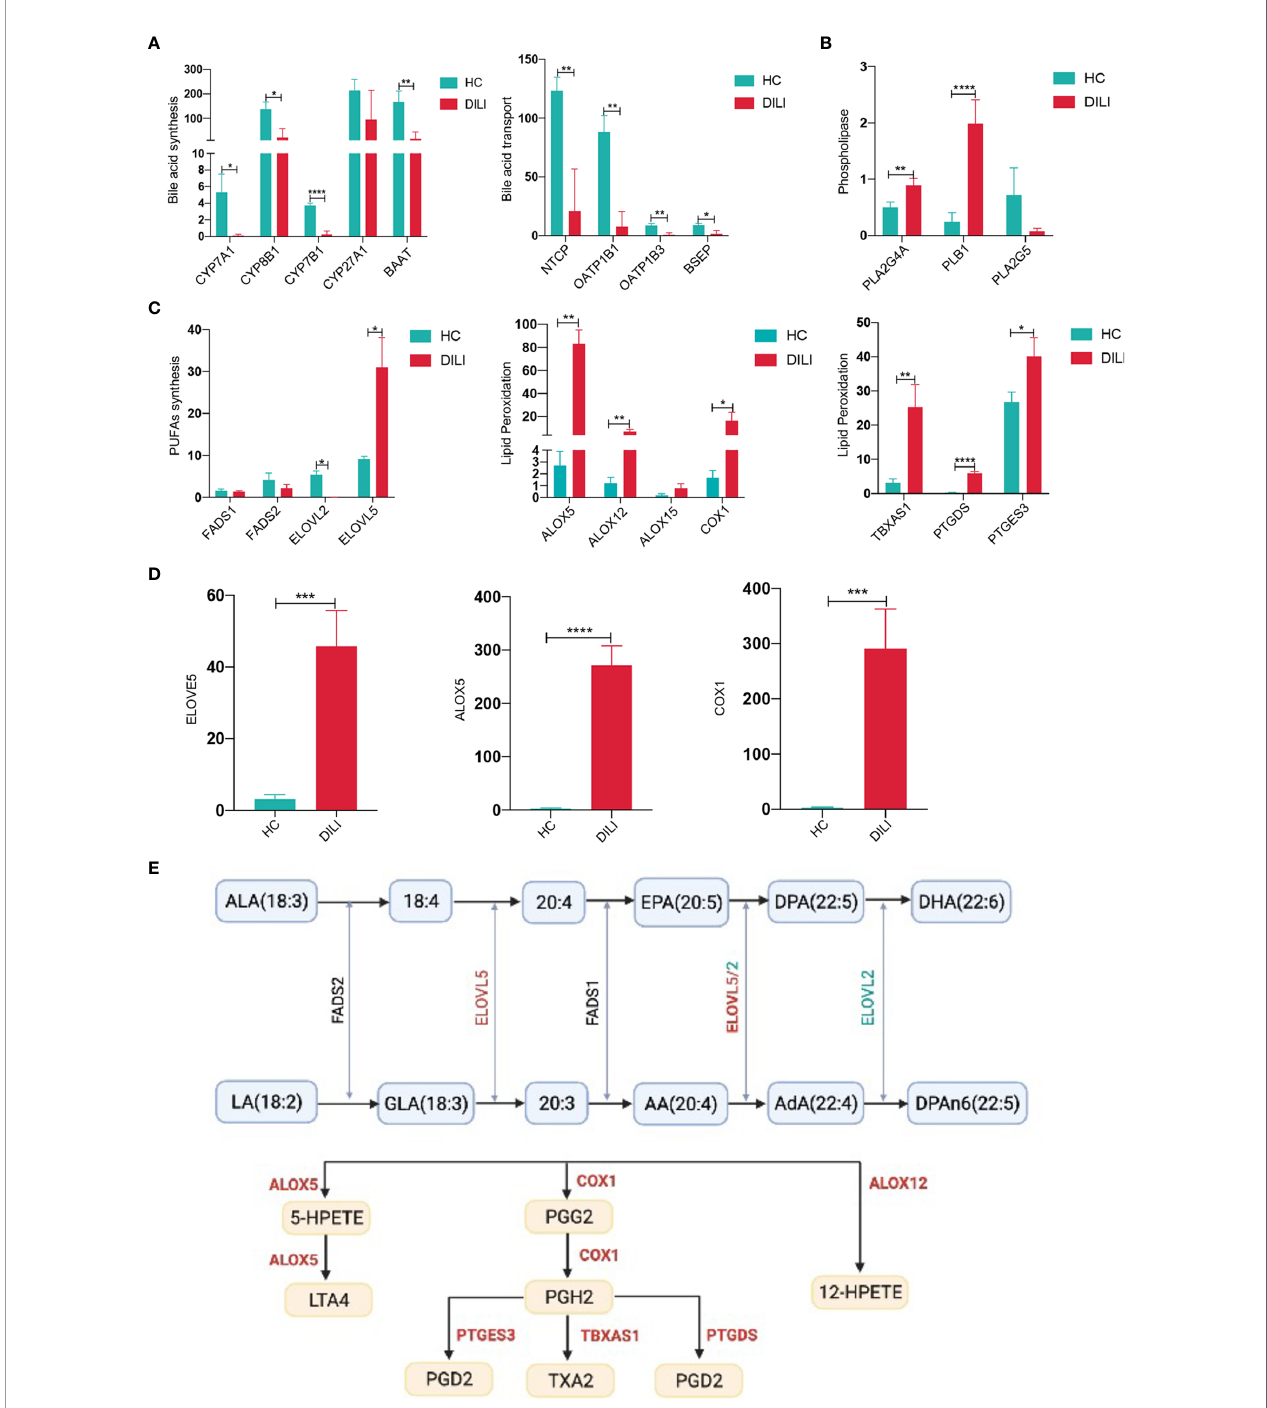
FIGURE 6 | BA and PUFA metabolism related gene expression in liver of HCs and DILI patients. (A) Gene expression associated with bile acid synthesis in liver of HCs and DILI patients. (B) Altered phospholipase related gene expression in liver of DILI patients. (C) Gene expression associated with PUFA metabolism and lipid peroxidation in liver of HCs and DILI patients. (D) Veri fi cation of ELOVE5 , ALOX5 and COX1 expression using qPCR. (E) A sketch map for the PUFA metabolism related enzymes (signi fi cant changes are shown as red for increase or green for decrease). *p < 0.05; **p < 0.01; ***p < 0.001; ****p < 0.0001. NTCP , sodium-BA cotransporter; OATP1B , organic anion transporting polypeptide 1B; BSEP , bile salt export pump; CYP , cytochrome P450; PLA2 , phospholipaseA2; PLB , phospholipase B1; FADS , fatty acid desaturase; ELOVL , elongation of very long chain fatty acids protein; ALOX , arachidonic acid lipoxygenase; COX, cyclooxygenase; TBXAS1 , thromboxane synthase 1; PTGDS , prostaglandin D2 synthase; PTGES3 , prostaglandin E synthase 3, LTA4, leukotriene A4; TXA2, thromboxane A2; PGG2, prostaglandin G2; PGH2, prostaglandin H2; PGD2, prostaglandin